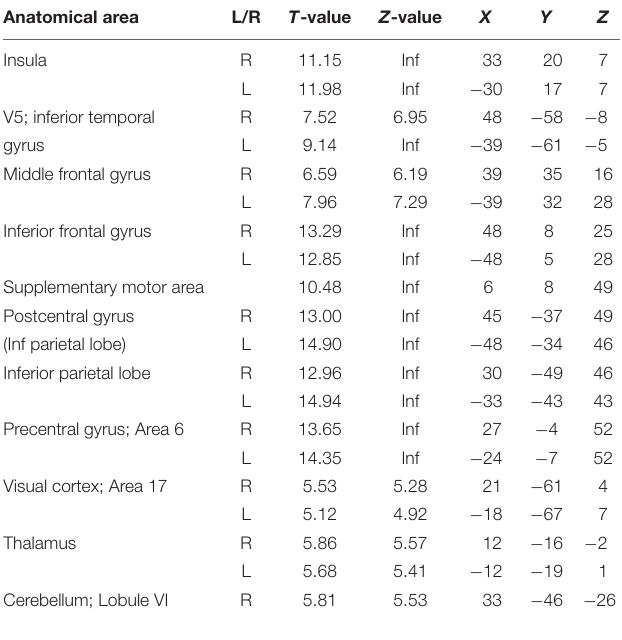
TABLE 1 | HRF model; positive modulation p < 0.05 (FWE corrected at the voxel level).